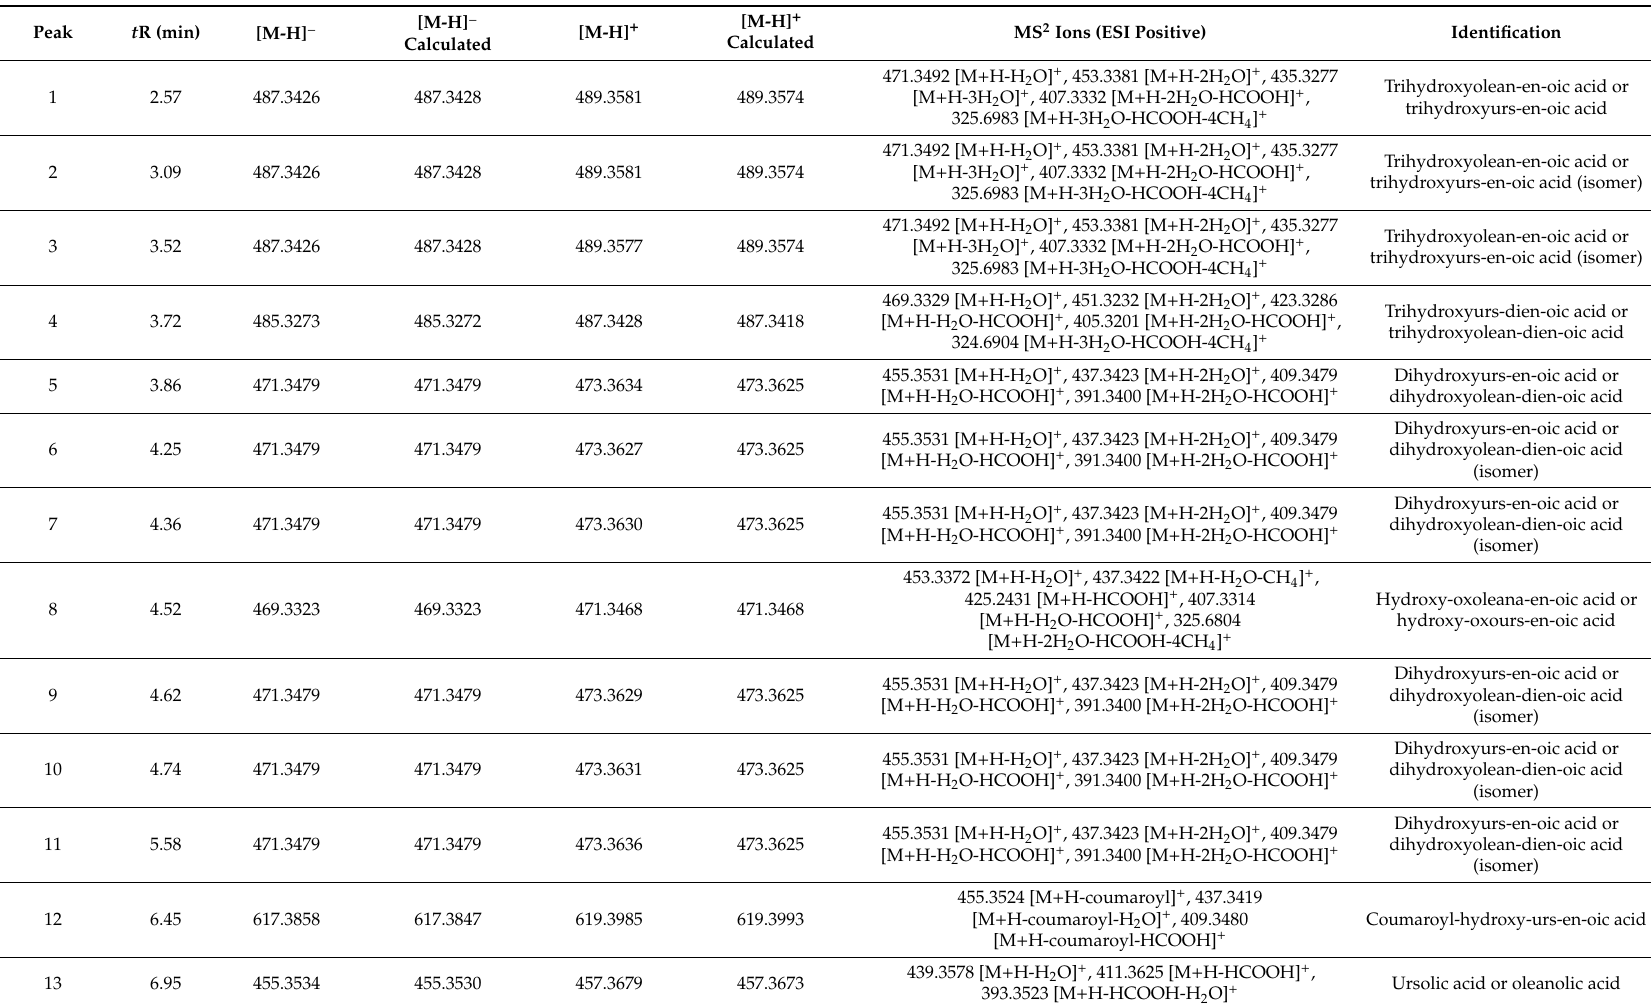
Table 2. Characterization of acid triterpenes of M. hirsuta fraction by UPLC /